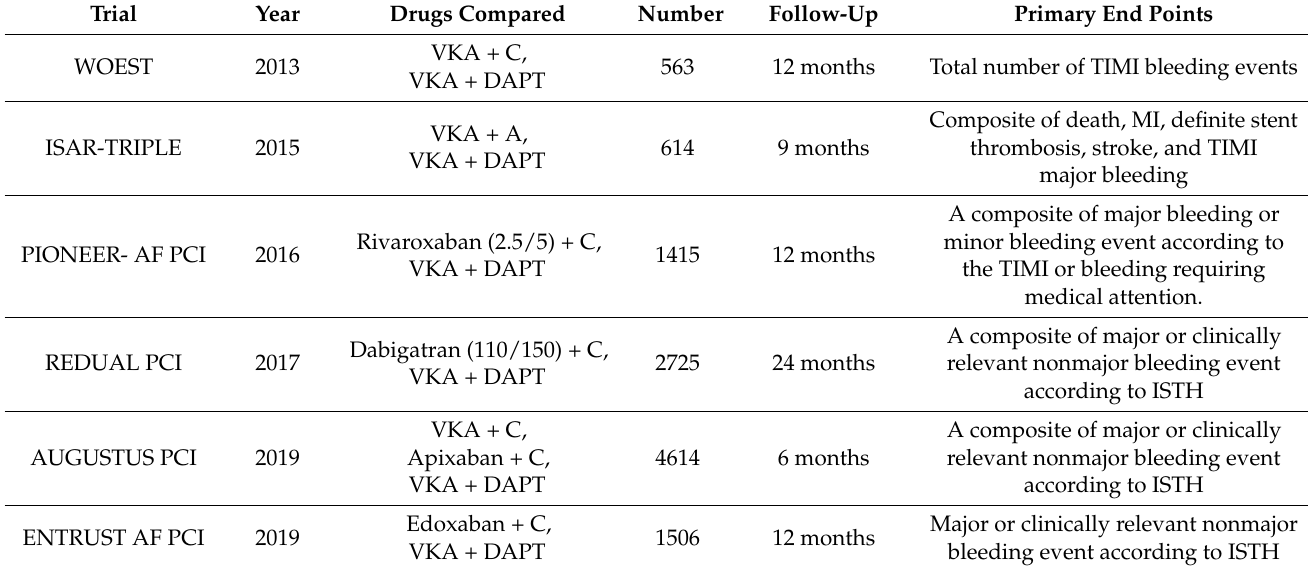
Table 1. Trials of oral anticoagulation therapy comparing dual therapy with triple therapy in pa- tients with atrial fibrillation with acute coronary syndrome. Notes: DAPT—dual antiplatelet; ISTH- International Society of Thrombosis and Hemostasis; VKA—vitamin K antagonist;